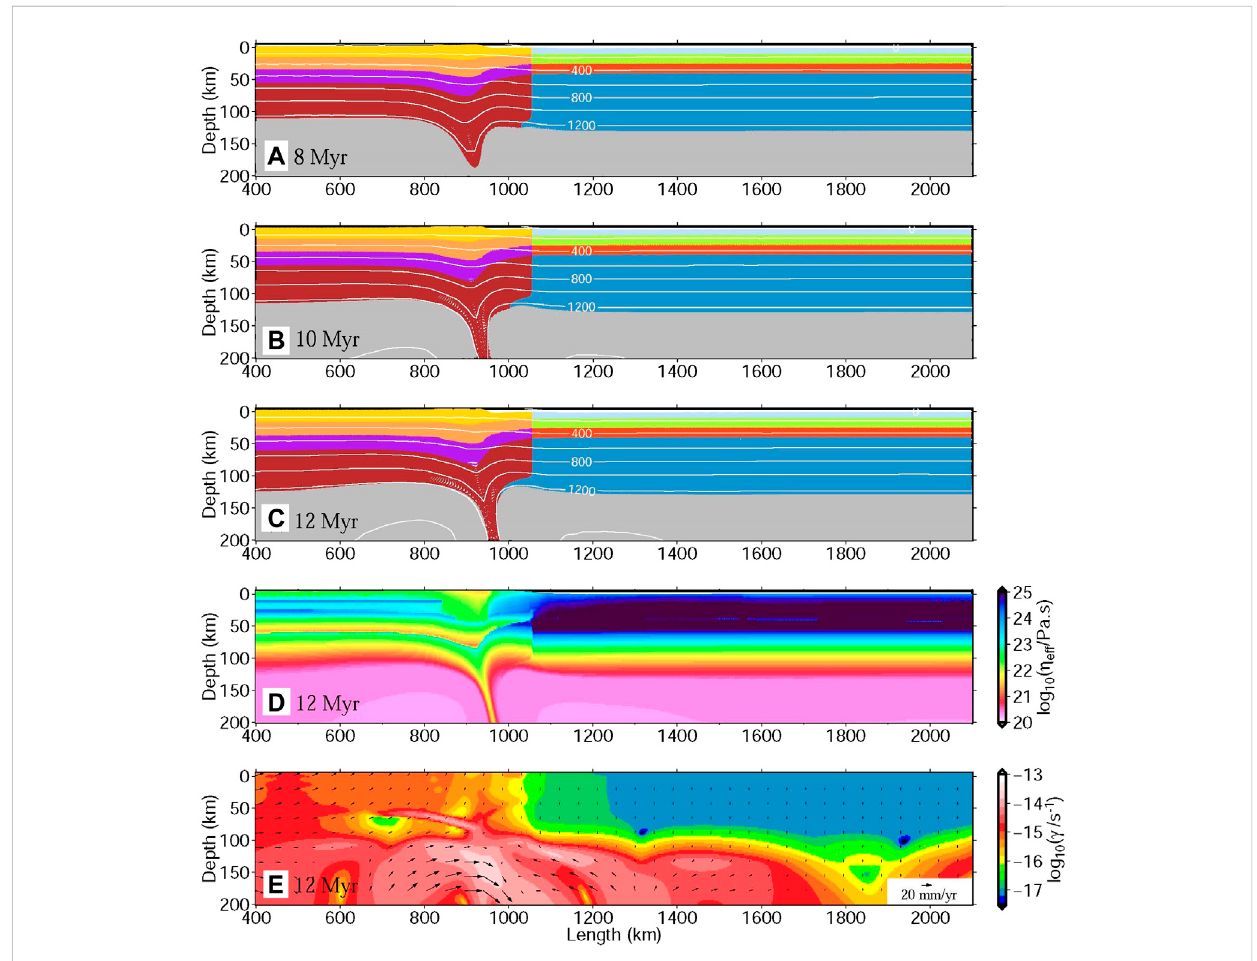
FIGURE 3 The evolution of lithospheric deformation (A – C) , effective viscosity (D) , and the maximum shear strain rate localization (E) for case R. White lines in (A – C) indicate the isotherm. Black arrows in (D) show velocity vectors.